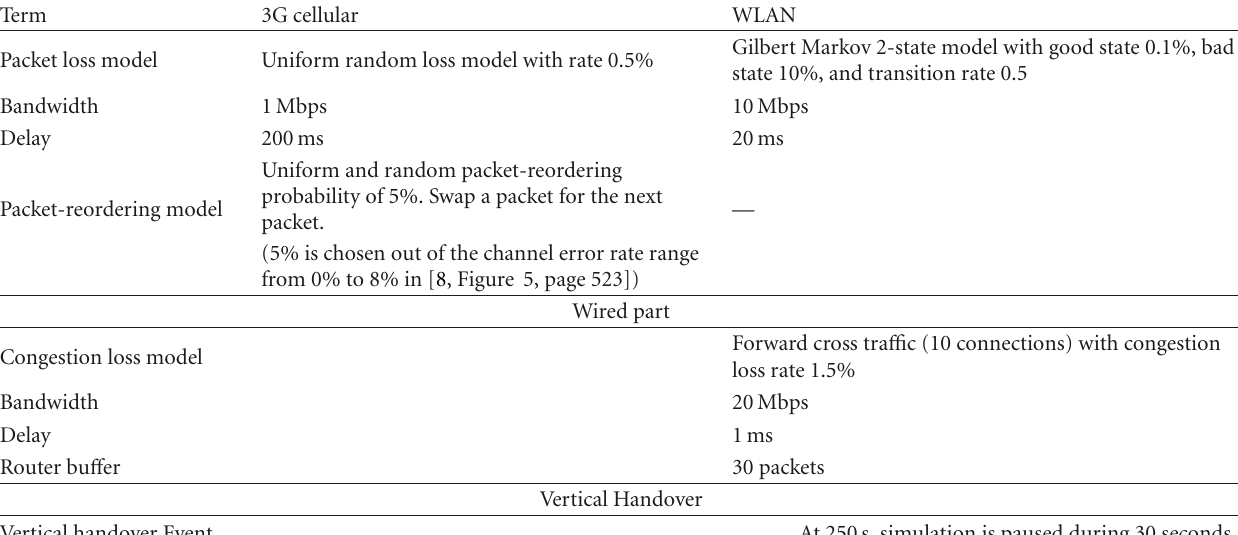
Figure 10: Network model for vertical handover. Table 1: Simulation